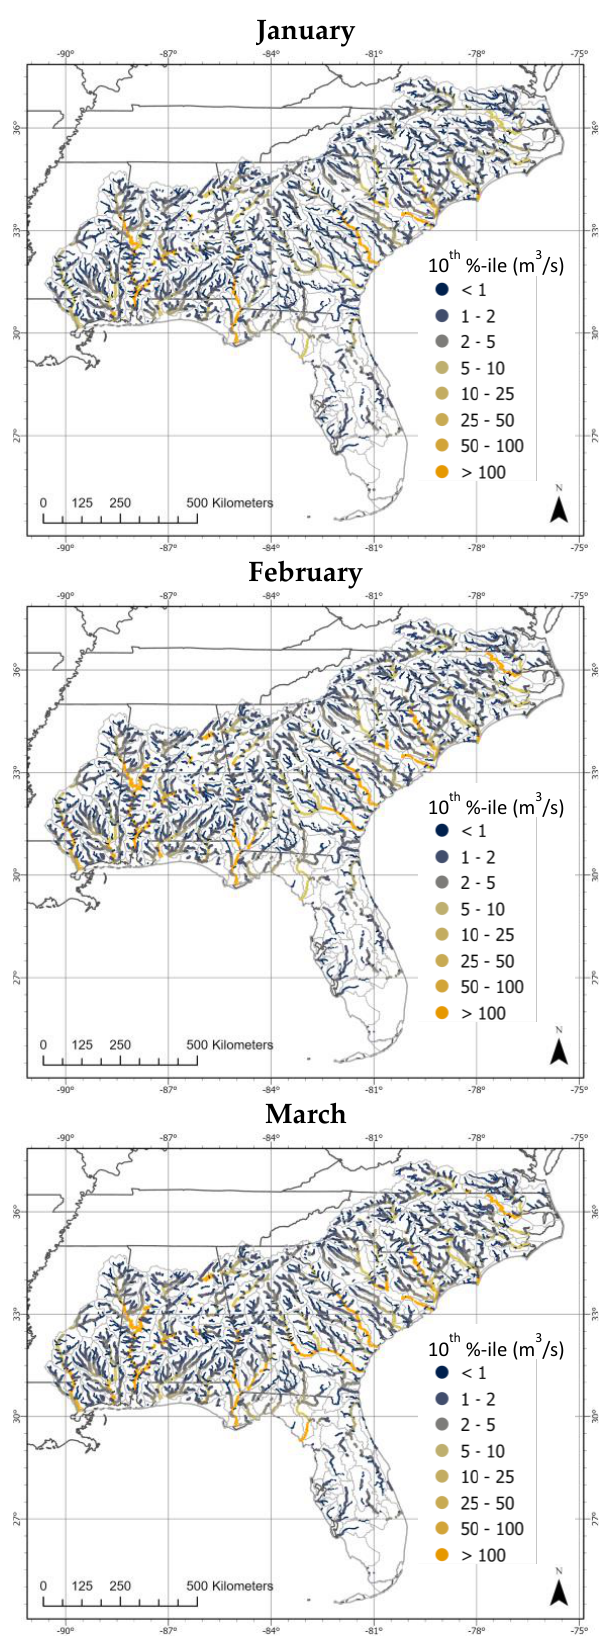
Figure 3. Cool season (January – March) patterns of 10th percentile threshold (m 3 /s) over the study region based on NWM retrospective simulations.